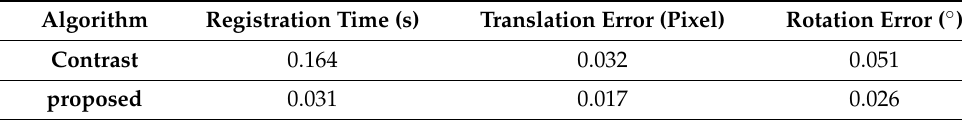
Table 3. Comparison of panoramic mosaic